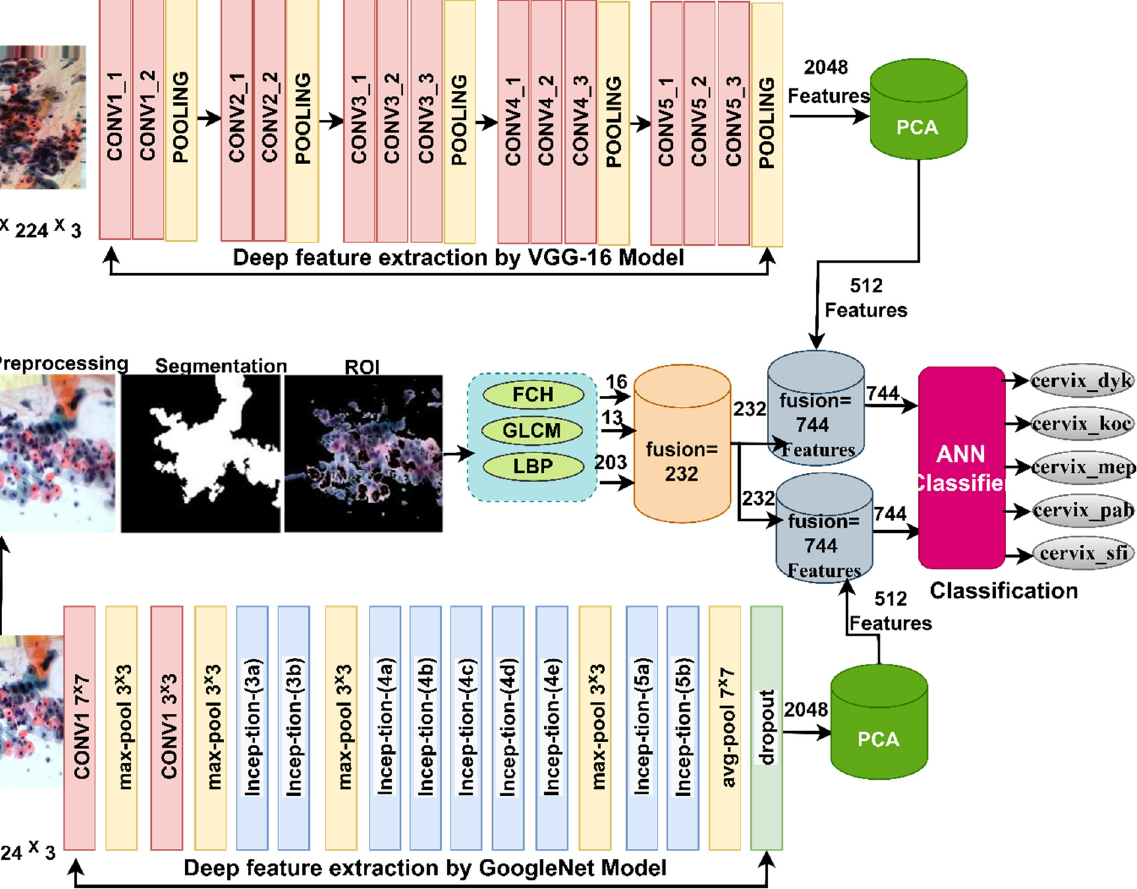
Figure 6. Framework for diagnosing abnormal cells of the cervical cancer data set based on fused features.